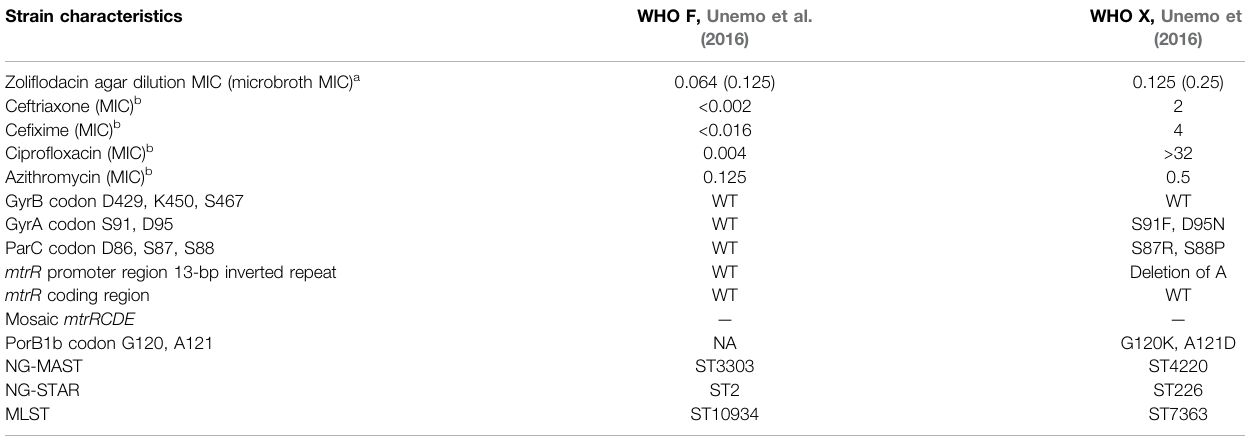
TABLE 1 | Relevant phenotypic and genetic characteristics of examined Neisseria gonorrhoeae strains. Strain characteristics